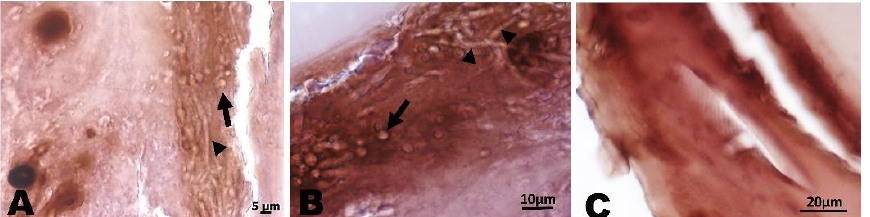
Figure 9. G. mellonella histopathology stained with hematoxylin and eosin. ( A , B ): C. albicans cells (arrow) and fungal hyphae (arrowhead) in infected G. mellonella larvae. ( C ): G. mellonella larvae treated with WMR peptide in combination with FLC.